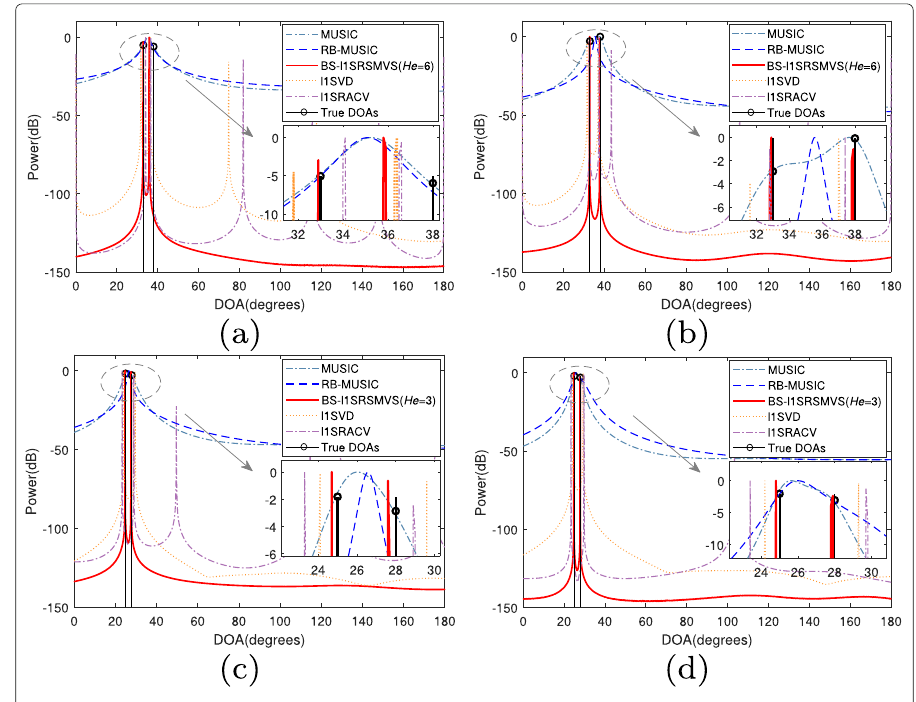
Fig. 7 Angular separation versus SNR of different methods, M =13, r /λ =0.5. a SNR=0dB, N =2000, DOAs=(33 ◦ ,38 ◦ ). b SNR=10dB, N =2000, DOAs=(33 ◦ ,38 ◦ ). c SNR=20dB, N =200, DOAs=(25 ◦ ,28 ◦ ). d SNR=30dB, N =200, DOAs=(25 ◦ ,28 ◦